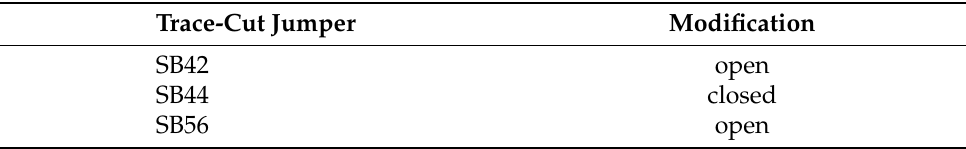
Table A3. Modification of the nRF52840 DK for disconnecting the reset